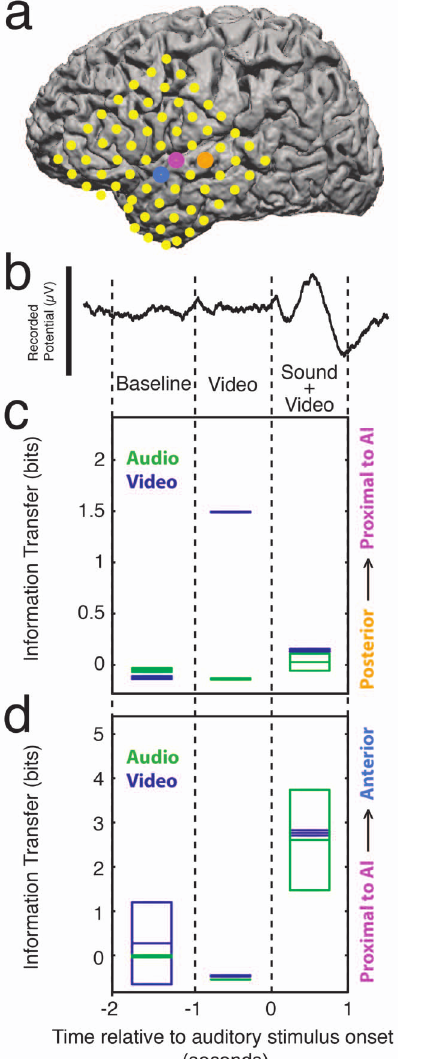
Figure 4. Transfer information in the superior temporal lobe. a, Electrode locations from Patient 1 for electrode location and information transfer directionality reference. b, An averaged evoked potential from the middle electrode is shown above the plots for reference. The scale bar for the evoked potential is 400 m V. c, Plot of information transfer between the posterior electrode and the electrode proximal to AI for 3-second time periods through the duration of the trial. d, Plot of information transfer between the electrode proximal to AI and the anterior electrode for 3-second time periods through the duration of the trial. For both b and c , positive values indicate transfer of information in the caudal–rostral direction, and negative values indicate transfer of information in the rostral–caudal direction. Green box plots indicate information about the identity of the audio stimuli. Blue plots indicate information about the video stimuli. Box plots show means and quartiles for the 5 hemispheres.